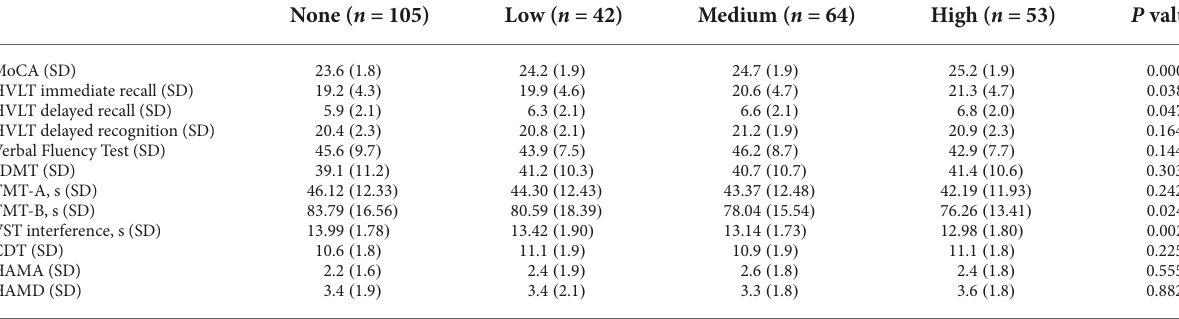
TABLE 5 The cognition differences of subgroup